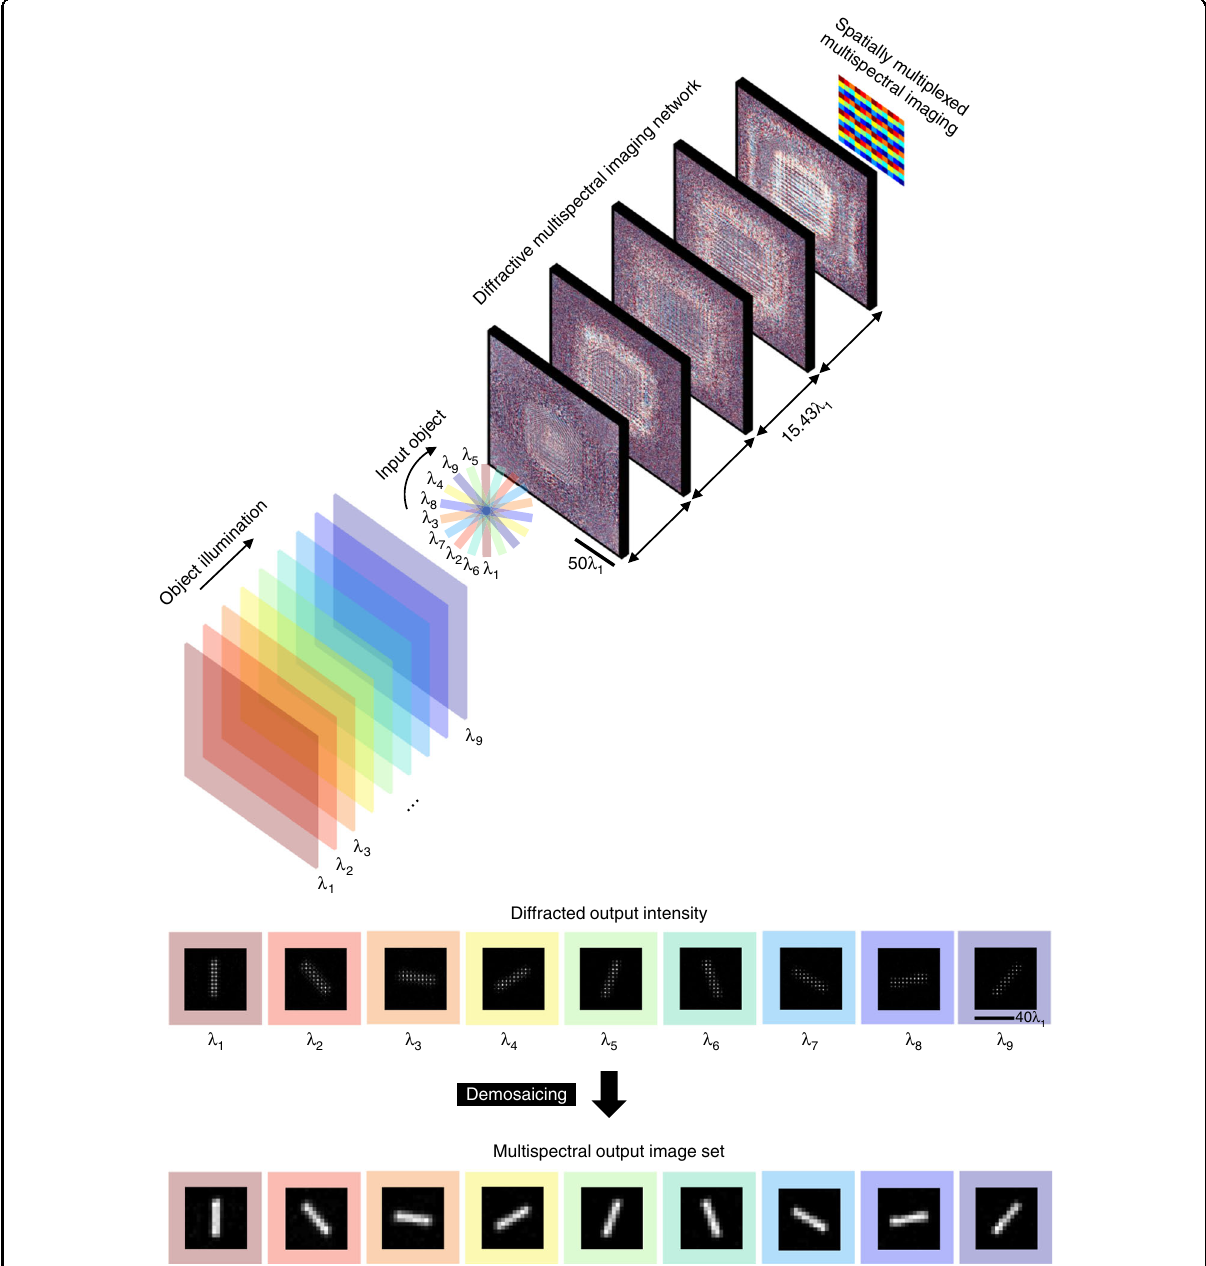
Fig. 1 The schematic of a diffractive multispectral imager. The depicted diffractive optical network simultaneously performs coherent optical imaging and spectral routing/ fi ltering to achieve multispectral imaging by creating a periodic virtual fi lter array at the output. In this example, 3 × 3 = 9 spectral bands per virtual fi lter array are illustrated; Figs. 4 – 5 report 4 × 4 = 16 spectral bands per virtual fi lter array. In alternative implementations, the diffractive multispectral network can also be placed behind the image plane of a camera (before the image sensor), transferring the multispectral image of an object onto the plane of a monochrome image